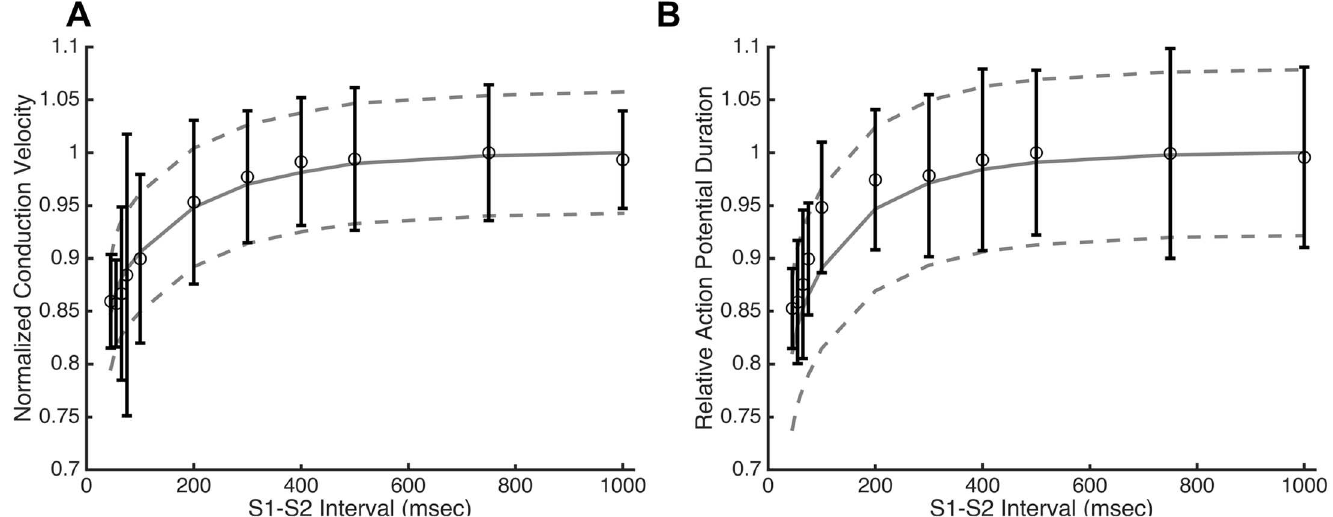
Fig 5. Ex293 restitution behavior. The base model (solid line) is able to closely mimic the experimentally observed(open circles) conduction velocity (A) and action potentialduration(B) restitution profiles (R 2 = 0.97 and 0.82, respectively). Model variability(dashedlines represent +/- 1 SD) approximates the degreeof experimental variability. Note that experimental data from [9] is plotted as mean ±